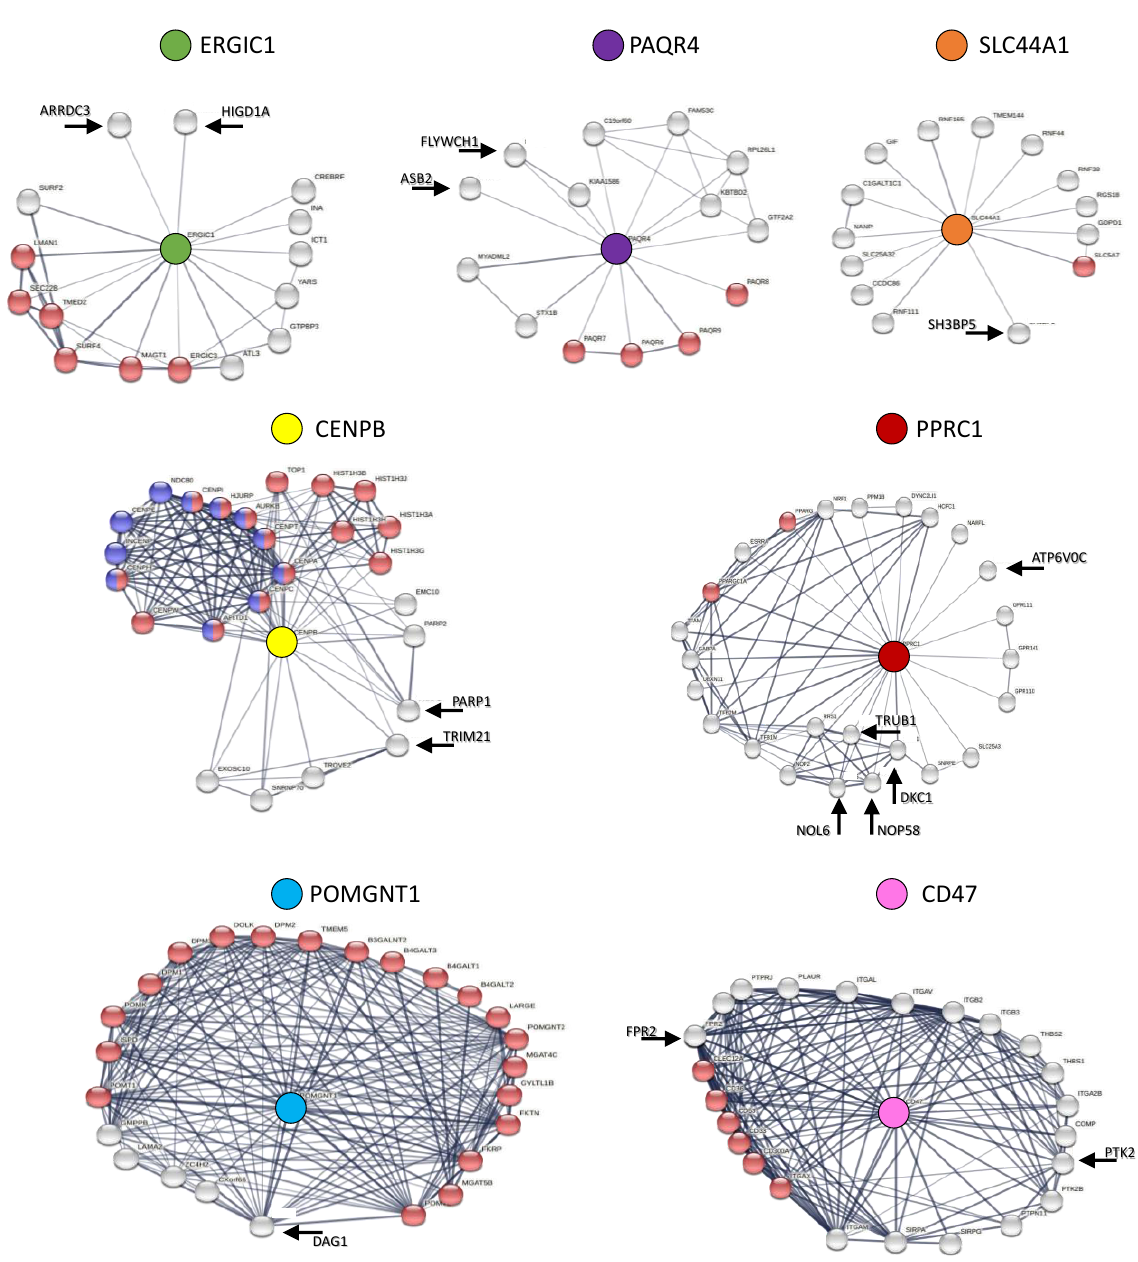
Figure 2. Functional interactions of the 7 candidate genes revealed by the STRING analysis. CENPB (yellow ball) mainly interacts with proteins involved in chromatin organization (red balls), and proteins involved in centromere formation (blue balls). ERGIC1 (green ball) mainly interacts with proteins involved in vesicle-mediated transport (red balls). PAQR4 (purple ball) mainly interacts with other adipoQ receptor (red balls). POMGNT1 (light-blue ball) mainly interacts with proteins involved in glycosylation (red balls). PPRC1 (brown ball) interacts mainly with other peroxisome proliferator-activated receptors (red balls). SCL44A1 (orange ball) interacts mainly with other choline transporters (red balls). CD47 (pink ball) interacts mainly with other CD proteins (red balls). Black arrows and conventional gene names indicate other functional interactors with documented involvement in cancer or programmed cell